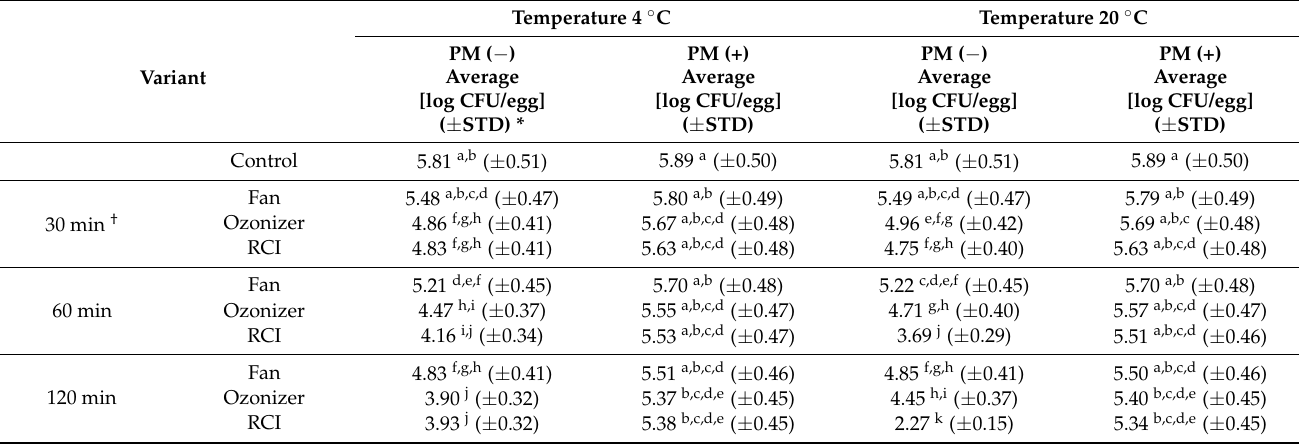
Table 4. The final number of Salmonella spp. on eggshells contaminated with bacterial suspension of 10 8 CFU/mL with or without the addition of poultry